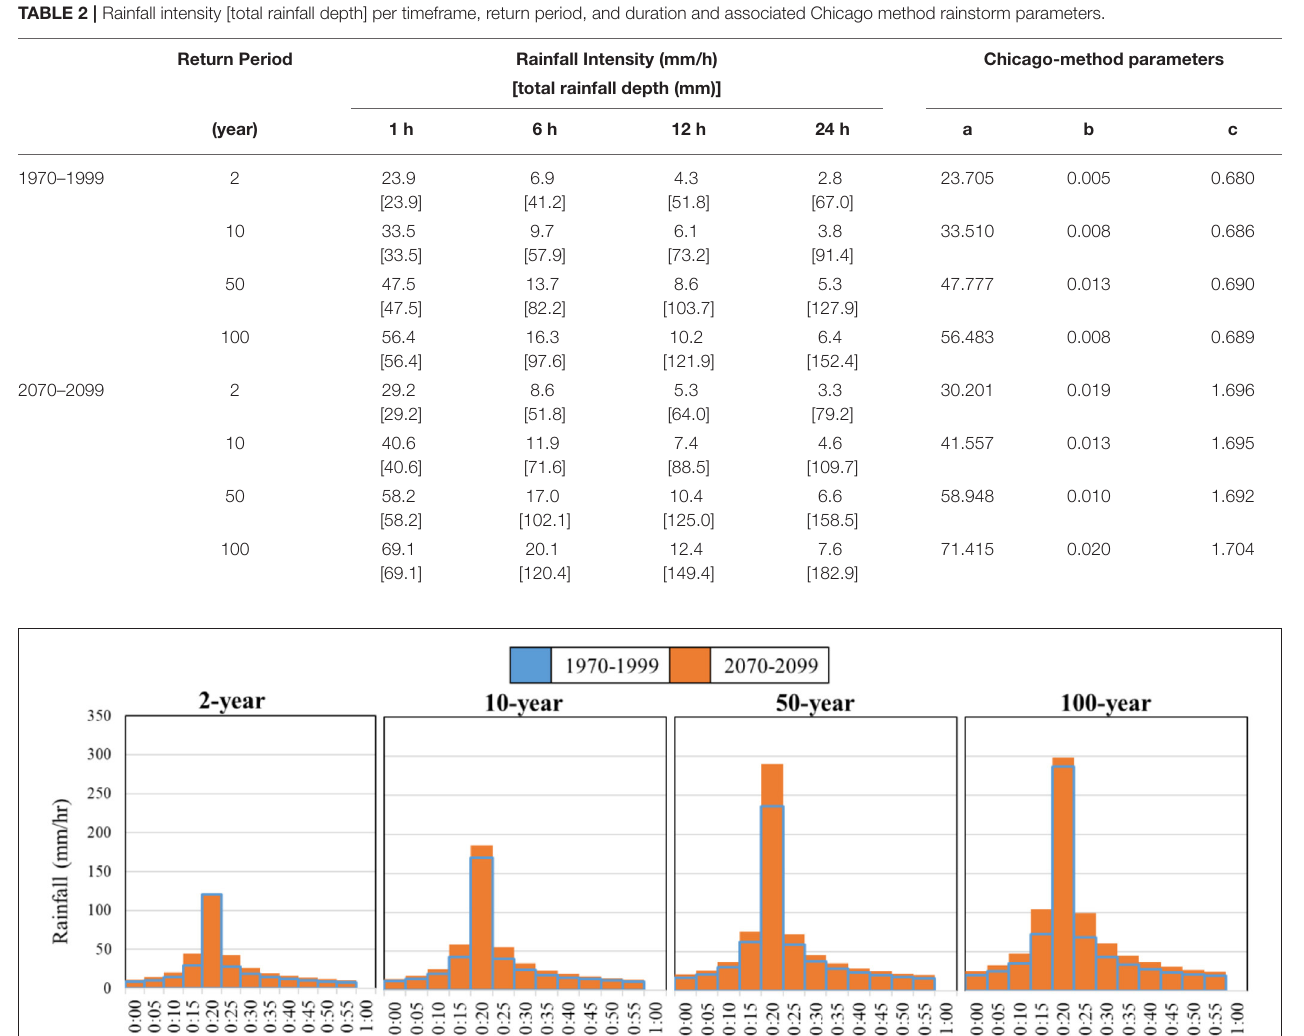
FIGURE 2 | One-h design storm hyetographs of 2-, 10-, 50-, 100-year return period from left to right. Period 1970–1999 in blue hollow columns and period 2070–2099 in orange solid columns.